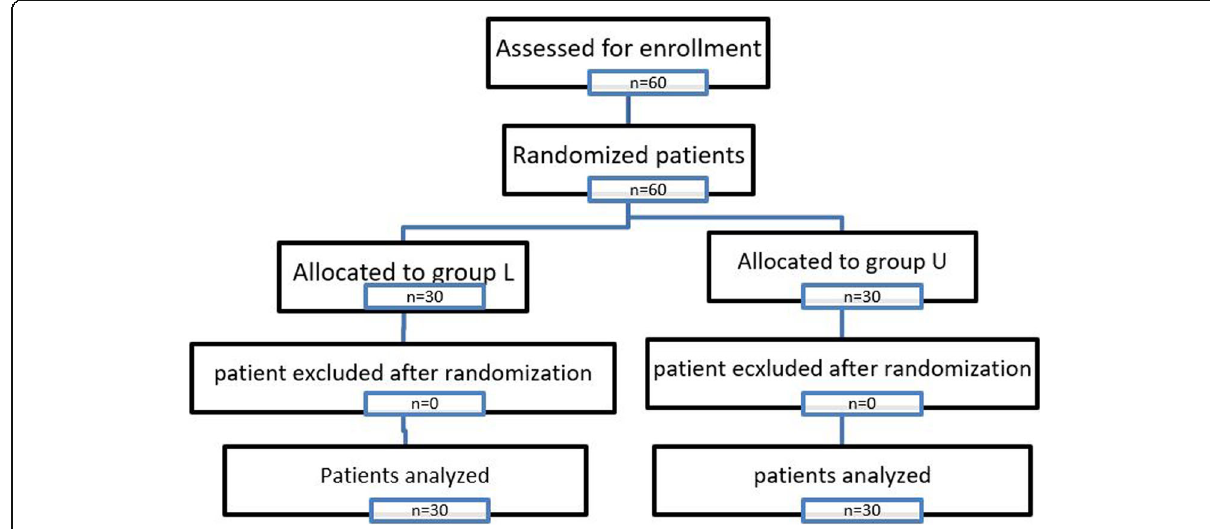
Fig. 2 Flow chart showing the patient recruited, randomized, and analyzed